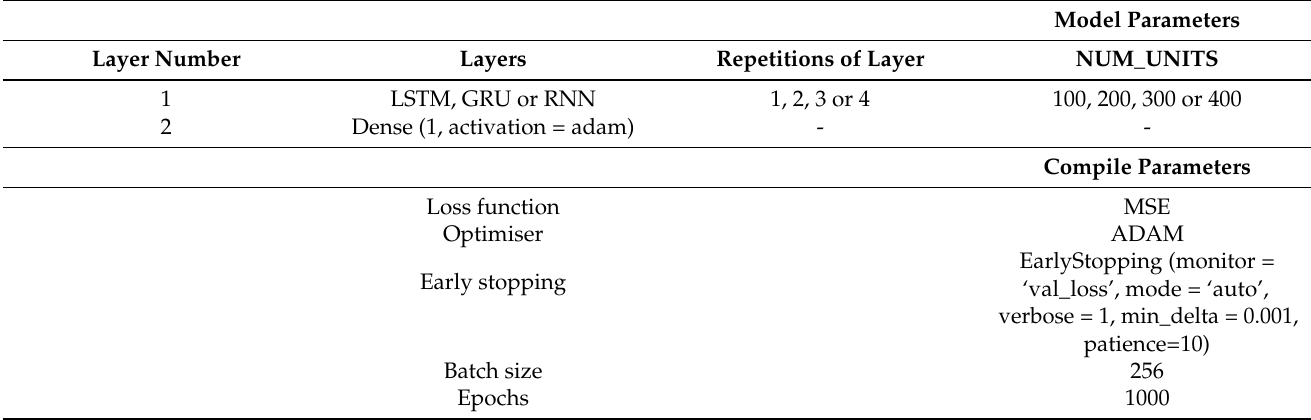
Table 4. Hyperparameters of the best deep learning model